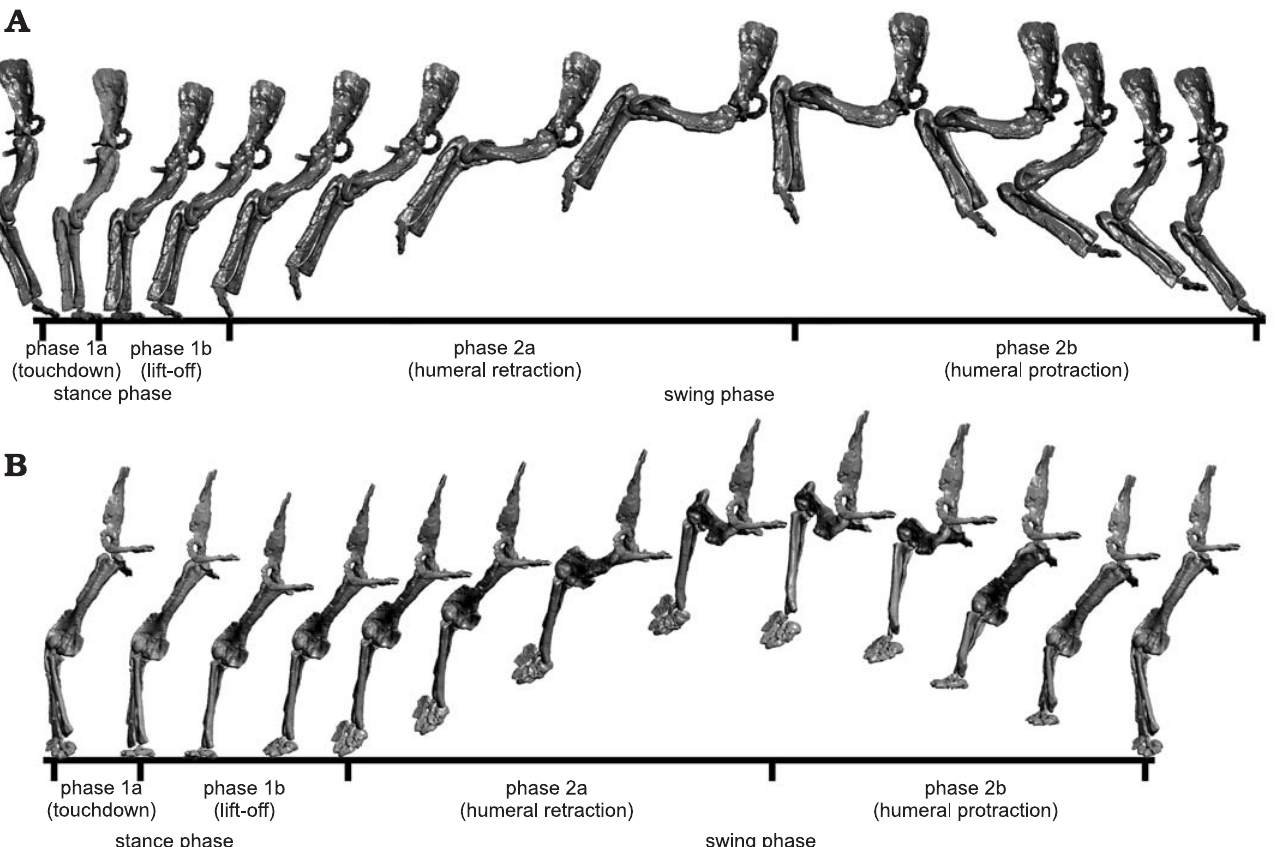
Fig. 7. Locomotory cycle of the right forelimb of Trucidocynodon riograndensis , in lateral ( A ) and anterior ( B ) views. The cycle begins with the leftmost image and its phases are those described in the